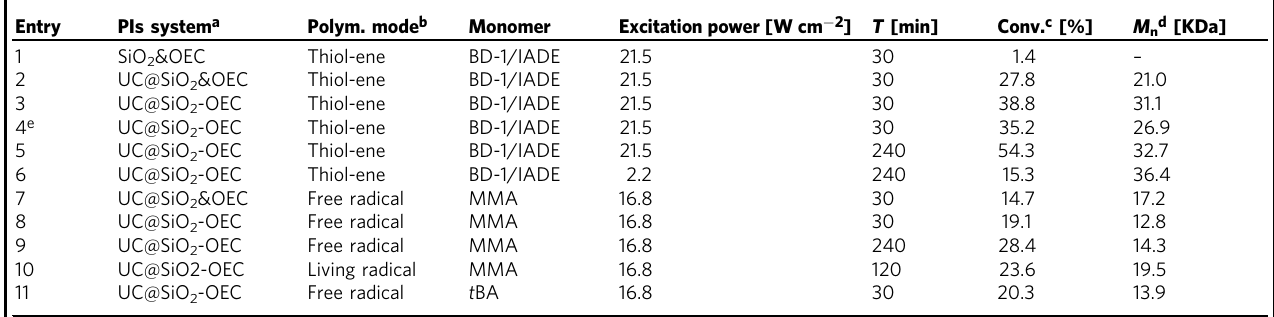
Table 1 UCNPs-assisted free radical and thiol-ene photopolymerizations with 980 nm NIR laser irradiation in